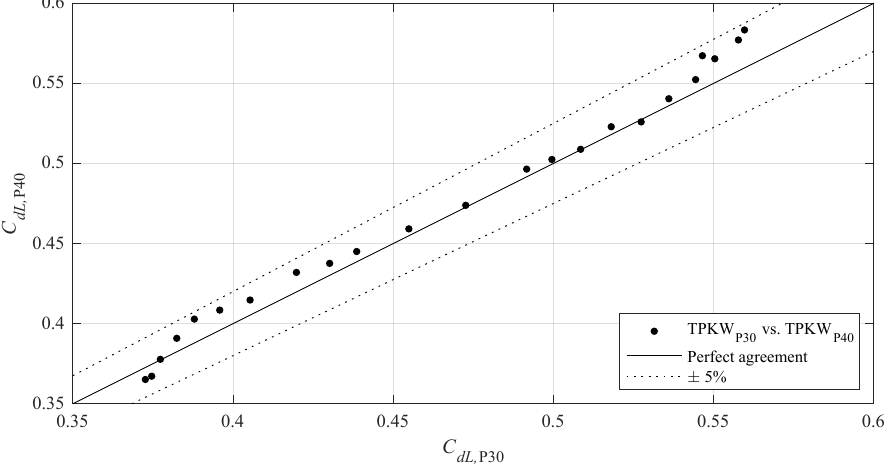
Figure 10. Comparison between TPKW P30 and TPKW P40 for the resulting C dL